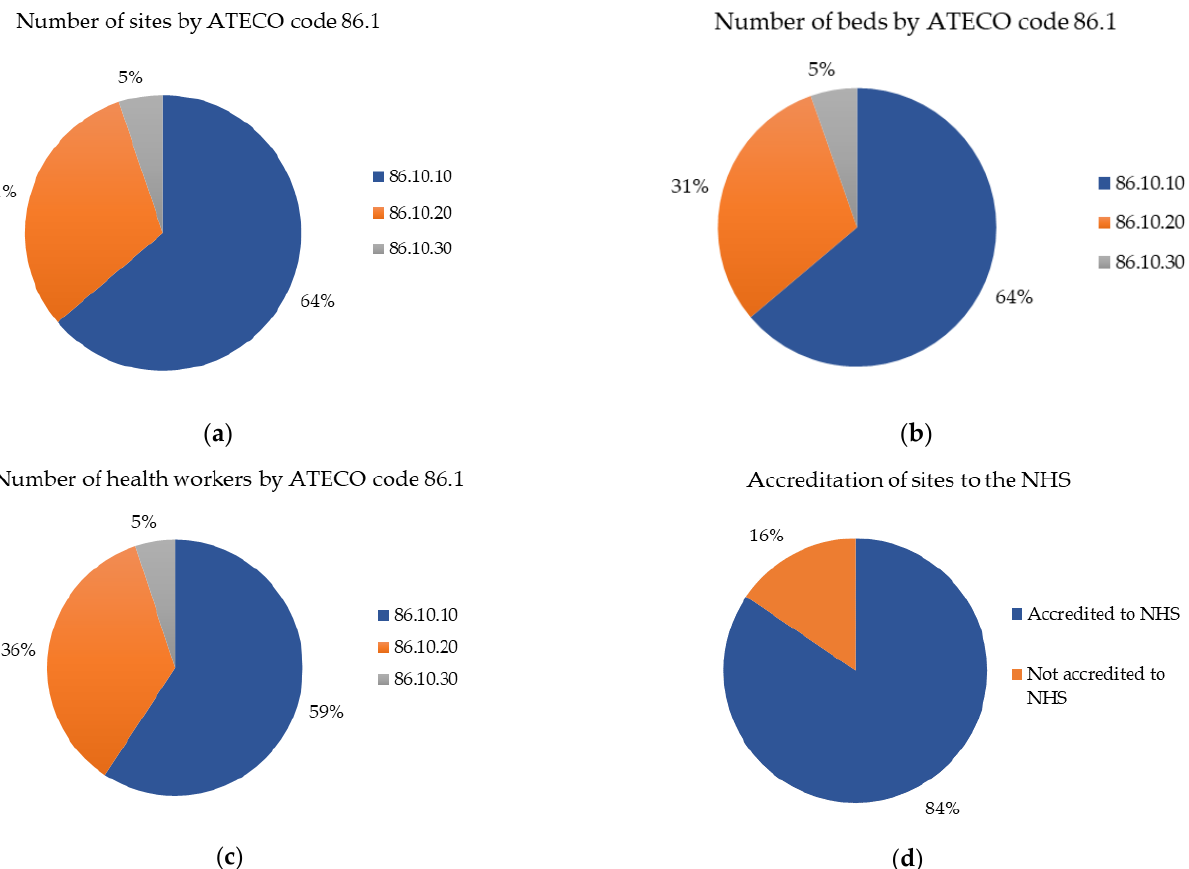
Figure 1. ( a ) Number of sites by ATECO code 86.1, ( b ) number of beds by ATECO code 86.1, ( c ) number of workers by ATECO code 86.1, and ( d ) accreditation of sites to the NHS.